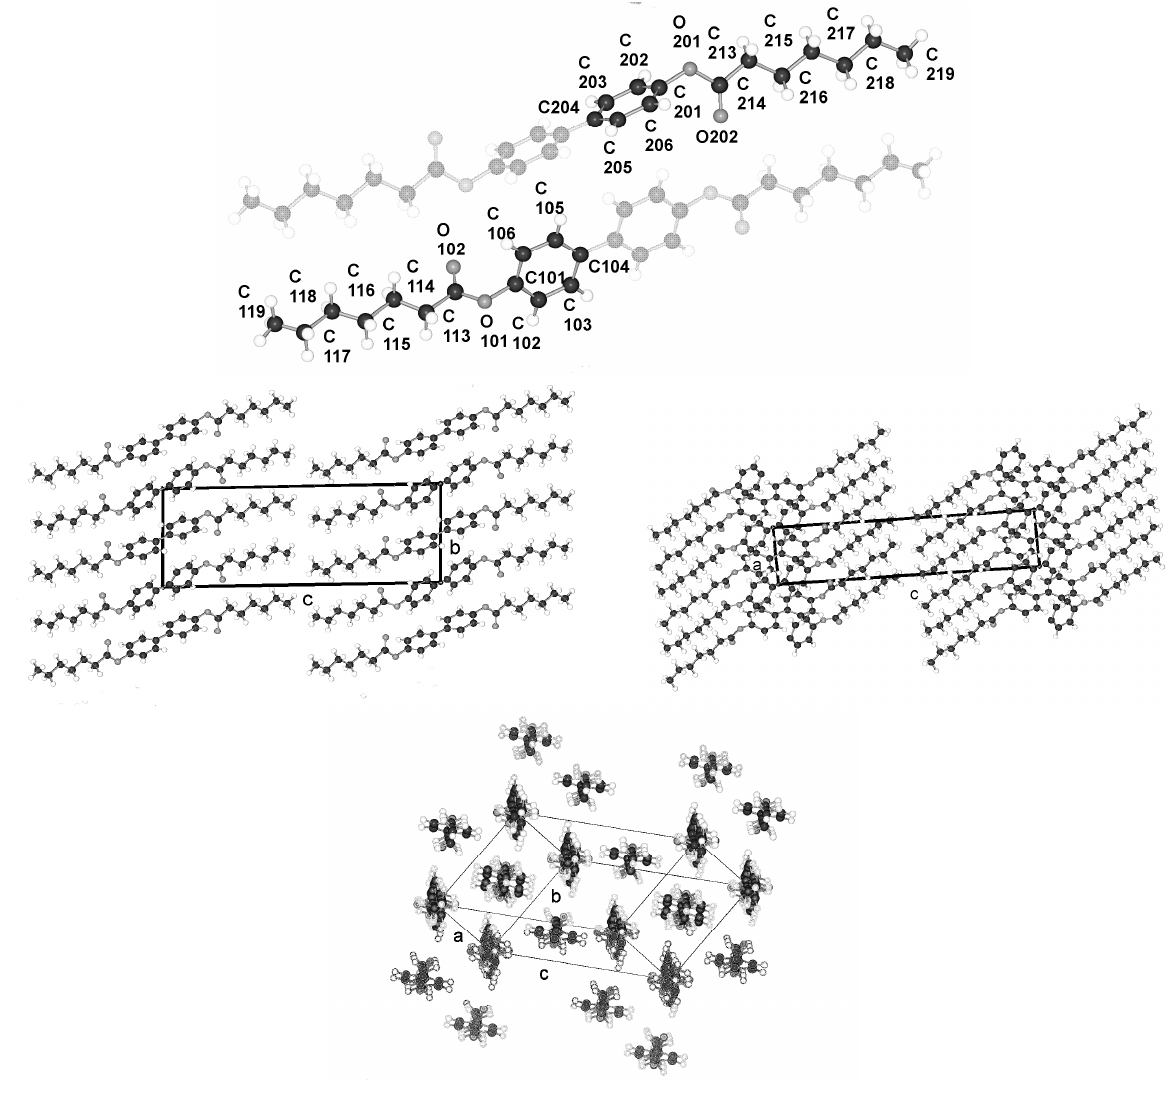
single but conformational different molecules by inversion centers. Such an inversion center, but within a single molecule and not within two molecules, is present for BP-2. For BP-6 unit 1 is linked by inversion symmetry to unit 1’ and unit 2 to the inverted unit 2’ that means the torsion angles of unit 1’ and 2’ exhibit opposite signs of unit 1 and 2, respectively. Due to the inversion symmetry within the molecules the adjacent phenyl rings lie coplanar for both molecules that is φ = 0 (Table 7b). Figure 21. Asymmetric unit of BP-6 (two half-molecules) and the corresponding symmetric units of the molecules linked by an inversion center between the two phenyl rings. Note the two phenyl rings are coplanar. Also represented are the packing arrangements on the a,c-plane, b,c-plane and the projection down the molecular strings. Equivalent representations are obtained for BP- n , n = 8, 11, 12, 13, 14, if the length of the alkane tails are taken into